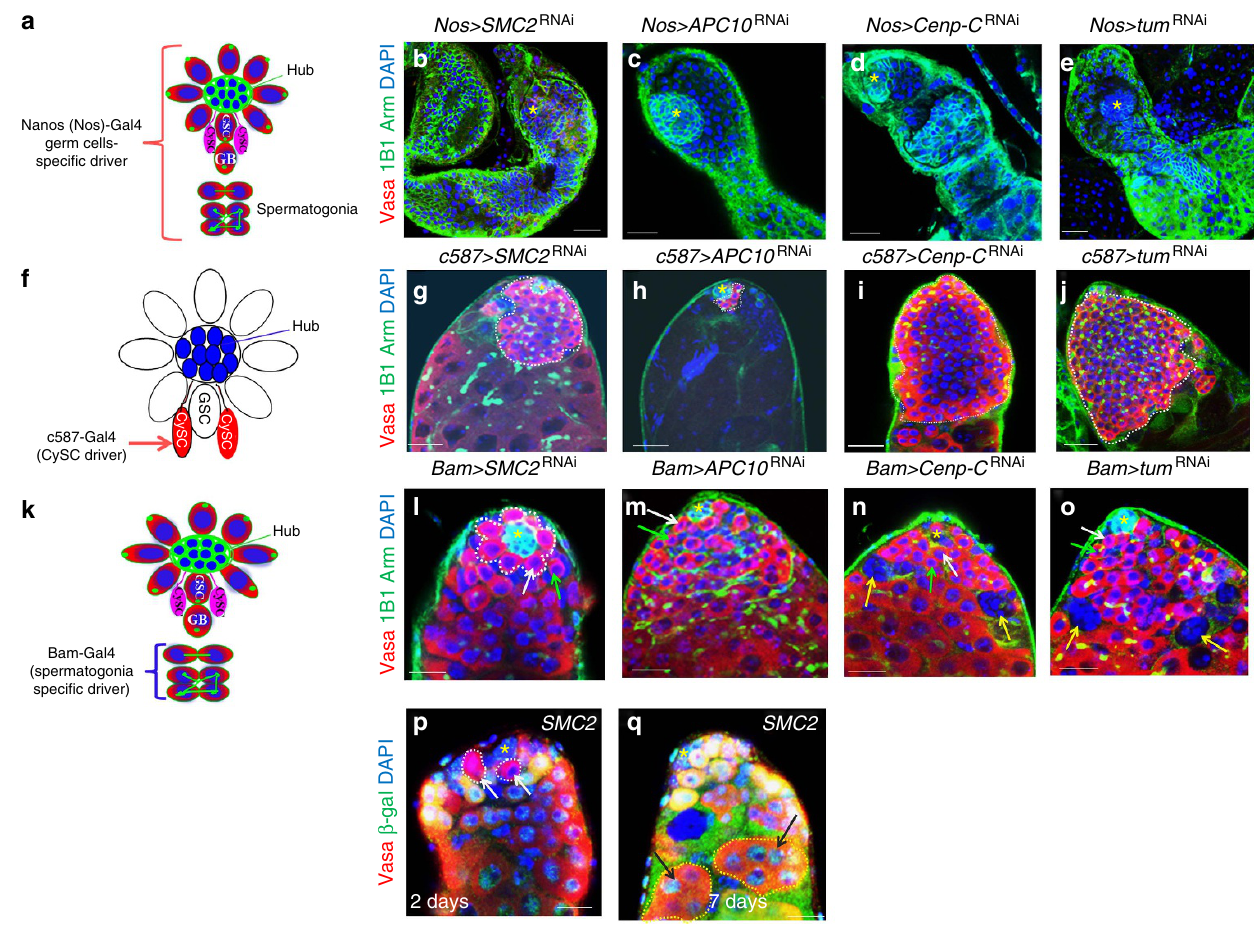
Figure 3 | Cell-type-specific knockdowns of mitotic/cytokinesis genes. ( a ) A schematic diagram showing expression pattern of Nos-Gal4 in adult testis. Knockdown of Smc2 ( b ), APC10 ( c ), Cenp-C (Centromeric protein-C) ( d ) and tum ( e ) in germ cells ( Nos-Gal4 ) resulted in dramatic GSC loss. ( f ) A schematic diagram showing expression pattern of c587-Gal4 in adult testis. Knockdown of Smc2 ( g ), Cenp-C ( i ) and tum ( j ) in CySC ( c587-Gal4 ) resulted in GSC differentiation defects (white dotted lines, g , i , j ); however, knockdown of APC10 ( h ) in CySCs resulted in GSC loss. ( k ) A schematic diagram showing expression pattern of Bam-Gal4 in adult testis. Knockdown of Smc2 ( l ) and APC10 ( m ) Cenp-C ( n ) and tum ( o ) in spermatogonial cells ( Bam-Gal4 ) resulted in normal ( l , m ) or polyploid ( n , o , yellow arrows) cells. ( p , q ) FRT 42D -SMC2 f06842 mosaic clones of GSCs 2 days ( p , white dotted lines with white arrows, b - galactosidase (green) negative) and 7 days ( q , yellow dotted lines with black arrows, b -galactosidase (green) negative) after clonal induction (ACI). Arm- negative GSC clones were detected in 4 out of 8 testes 2 days ACI but in 0 out of 20 testes 7 days ACI. Therefore, SMC2 is intrinsically required for GSC maintenance. Testes of the indicated flies were dissected, stained with antibodies to Vasa (red, marks all germ cells including GSCs), Arm (green, hub cells at the apex), 1B1 (green, marks round spectrosomes and branched fusomes) and DAPI (blue, marks the nuclei) in b – o , and analysed by confocal microscopy. White arrows near hub cells indicate GSC and green arrows indicate GBs (in l – o ). Asterisks indicate hub cells. The flies were cultured at 29 (cid:2) C for 7 days in b – o . Scale bars, 10 m